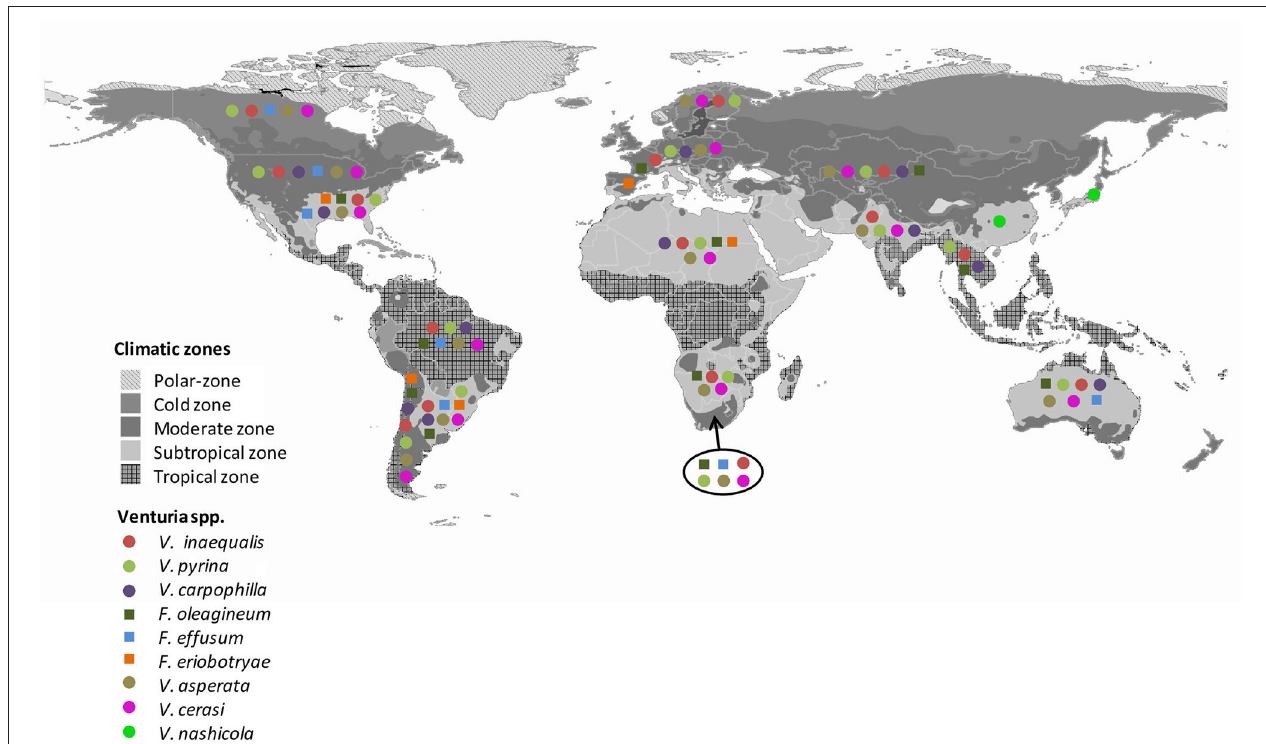
FIGURE 2 | Worldwide distribution of Venturia spp. Gray colors indicate the climate regions proposed by Kottek et al. (2006). Colors and symbols indicate the presence of the different Venturia spp. in each region. Data are from Plantwise and EPPO